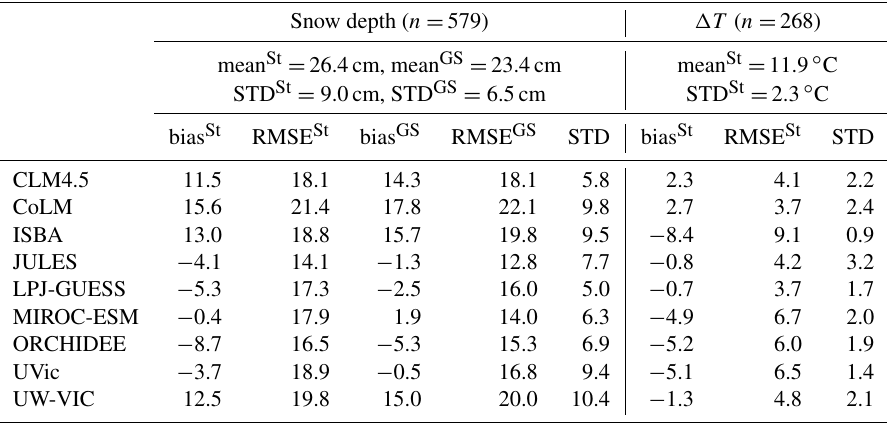
Table 3. Russian station location averaged error statistics for snow depth (cm) and temperature difference between 20cm soil and air temperature ( (cid:49)T ; ◦ C) for winter 1980–2000. For each variable, the maximum available number of observations ( n ) is used. Mean St,GS and STD St,GS are the observed mean and interannual variability (standard deviation), while STD is the standard deviations of each model. Bias is the mean error “simulation minus observation” and RMSE is the root mean square error. The statistics for snow depth are given based on both station observation (St) and GlobSnow (GS)